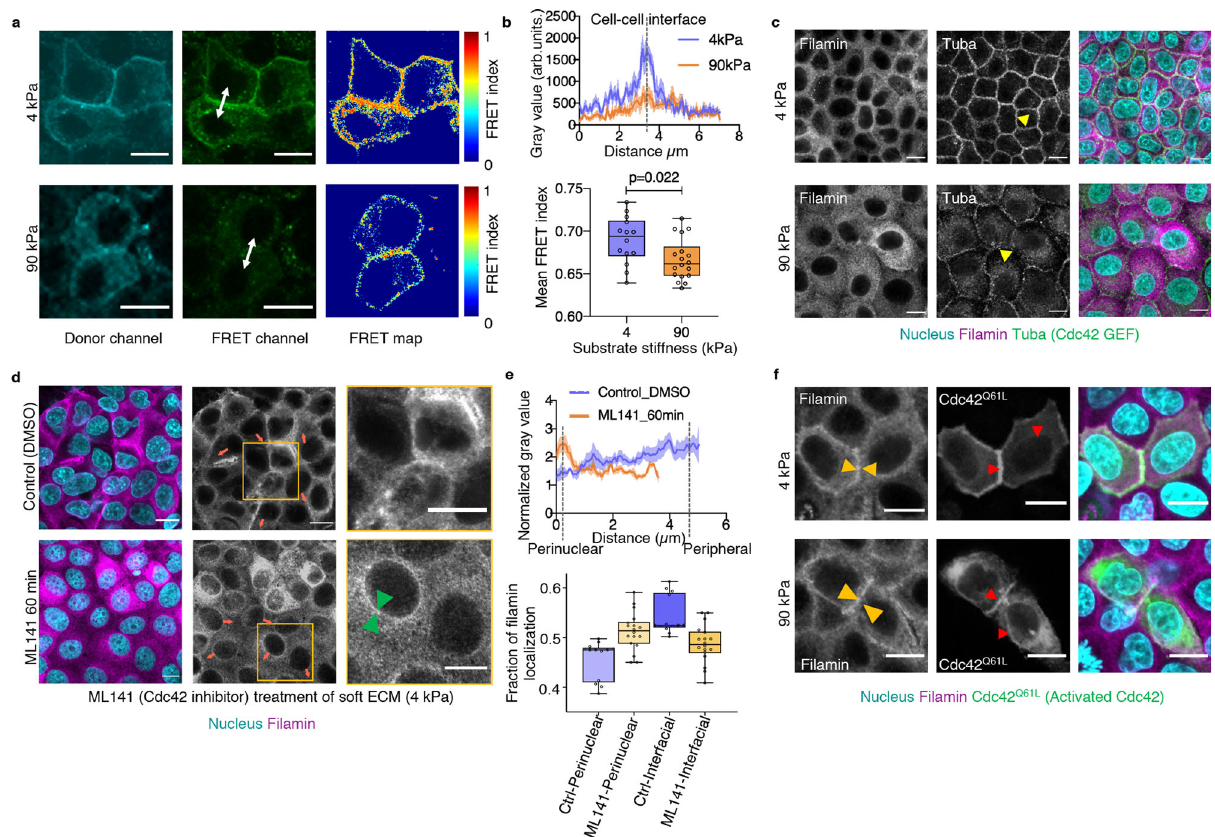
Fig. 3 Interaction with Cdc42 determines interfacial fi lamin localization. a Raichu-Cdc42 FRET biosensor expressed in MDCK-WT cells cultured on soft ( top ) and stiff ( bottom ) ECM. b ( Top ) Line scan of grey values from the FRET channel (representative white double-arrowed line in ( a ) from multiple cells cultured on both soft and stiff ECM indicate higher FRET values at cell – cell interface on soft ECM. Bold line plot depicts the mean grey values with the shaded region accounting for mean ± s.e.m of grey values from n = 10 (4 kPa) and 8 (90 kPa) cells. ( Bottom ) Box-and-whiskers plot of mean FRET index from soft and stiff ECM shows a signi fi cant reduction in cells cultured on stiff ECM, indicative of higher Cdc42 activity on soft ECM. Statistical signi fi cance was assessed using unpaired Student ’ s t -test with Welch ’ s correction (two-tailed). n = 14 (4 kPa) and 18 (90 kPa). c Immuno fl uorescence images of MDCK-WT cells co-stained for fi lamin and Tuba (Cdc42-GEF). Yellow arrowhead indicates enrichment of Cdc42-GEF at the interfacial region on soft ECM (top) and at the perinuclear region on stiff ECM (bottom). d Immuno fl uorescence images of MDCK-WT cells cultured on soft ECM treated with Cdc42 inhibitor: control DMSO ( top ) or ML141 ( bottom ) and immunostained for fi lamin. Green arrowhead indicates enrichment of fi lamin at the perinuclear region on soft ECM ( bottom ) post-treatment with ML141. Red arrowheads indicate the direction of line scans, starting from near the nucleus and extending to periphery e. ( Top ) Line scan of normalized grey values of fi lamin along red lines from multiple cells in ( d ) shows perinuclear fi lamin enrichment peaks with ML141 treatment ( orange line ). The bold line plot depicts the mean grey values with the shaded region accounting for mean ± s.e.m of grey values from n = 5 cells. ( Bottom ) Box-and-whiskers plot of the fraction of fi lamin localization in cells cultured on soft ECM and treated with ML141 ( orange ) or without treatment ( Ctrl, blue ). n = 13 (Ctrl) and 18 (ML141 treated) cells. f MDCK-WT cells transfected with constitutively active Cdc42 (Cdc42 Q61L ) and immunostained for fi lamin. Yellow arrowheads indicate increased interfacial enrichment of fi lamin on stiff ECM. Red arrowheads indicate enriched areas of constitutively active Cdc42. Scale bars = 10 μ m. For boxplots, the centre line denotes the median, the box displays the interquartile range, whiskers indicate the range not including outliers (1.5× interquartile range). Source data ( b , e ) are provided as a Source Data fi